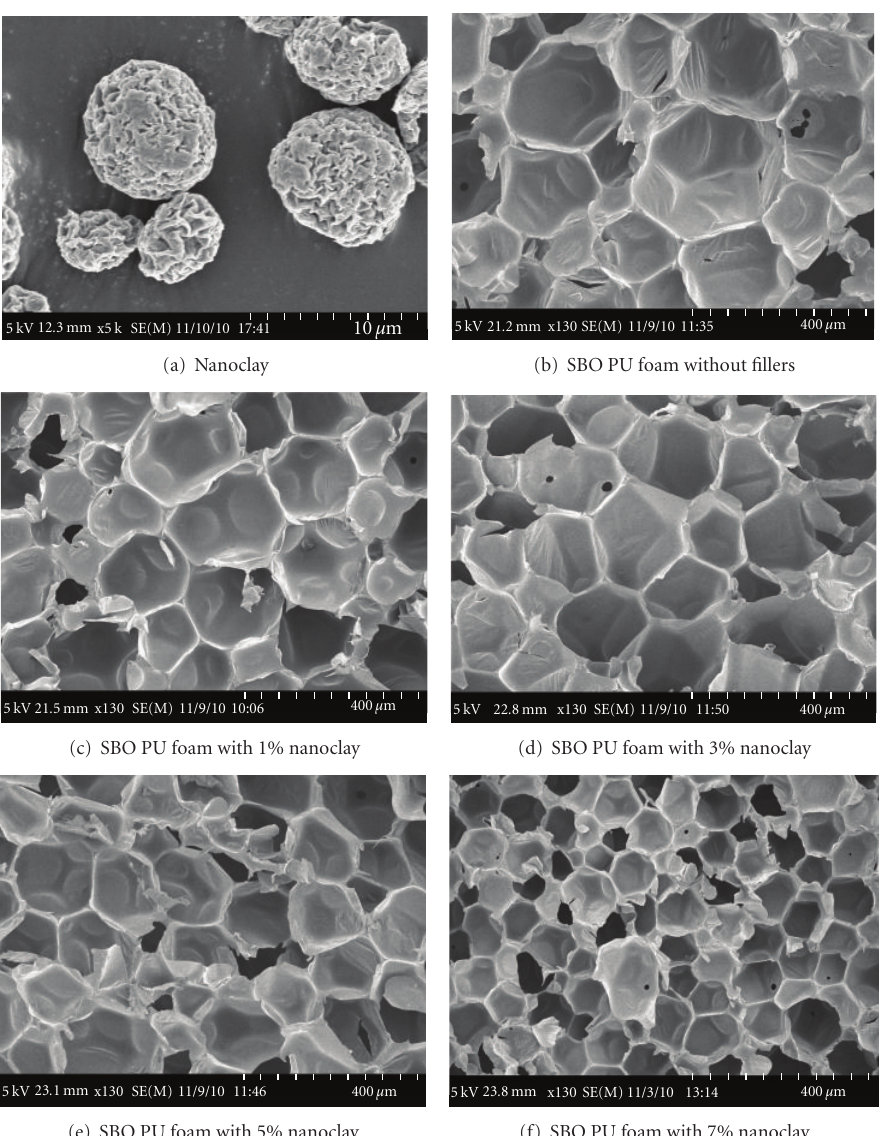
Figure 4: Scanning electron micrographs of SBO PU foams modified with